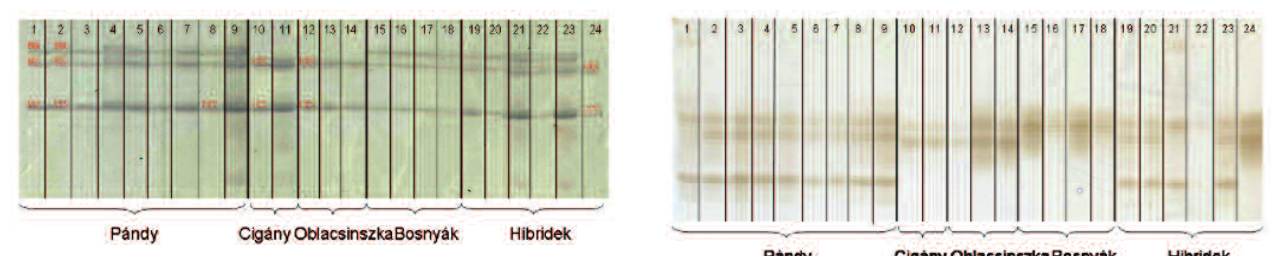
Figure 3. Silver stained microsatellite DNA profiles of the 24 investigated Hungarian sour cherry cultivars with primer pair PS08E08